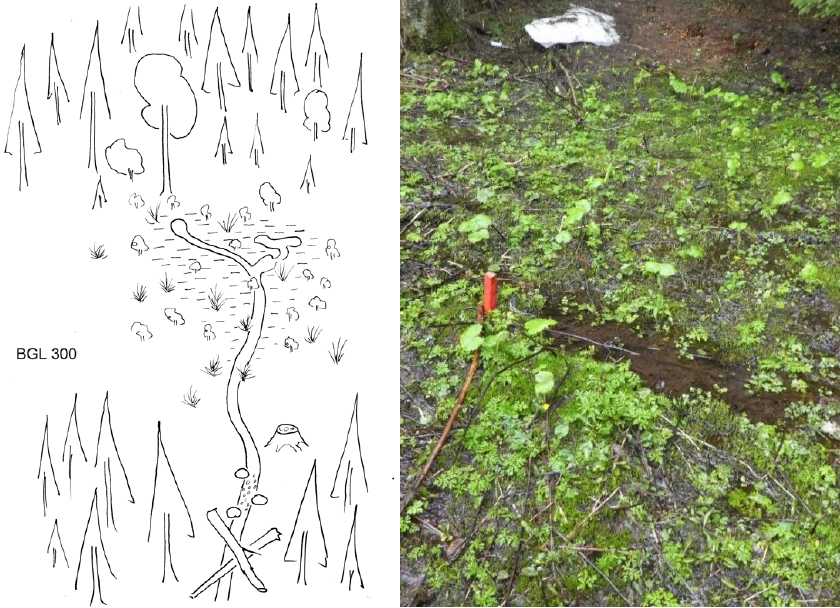
Figure 3. Sketch of the spring area ( left ) and marking of the spring mouth in Berchtesgaden National Park ( right ).